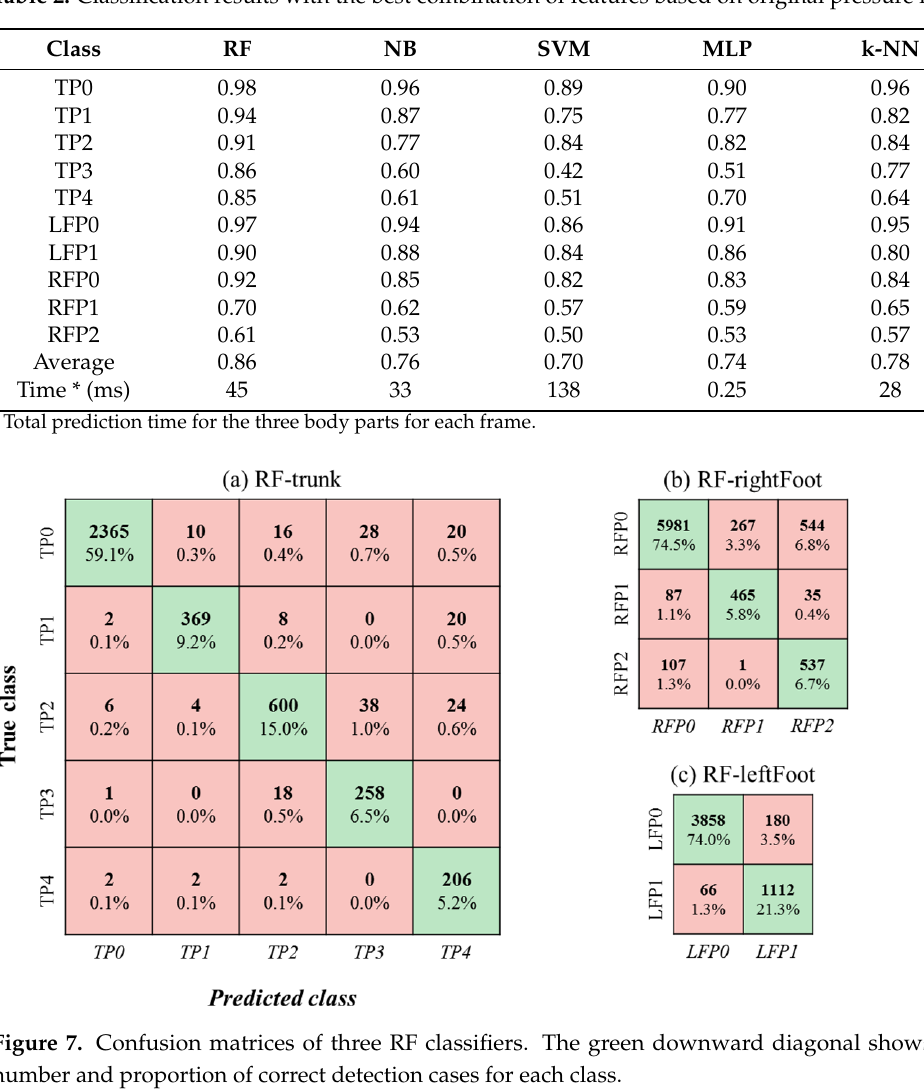
Table 2. Classification results with the best combination of features based on original pressure mats.